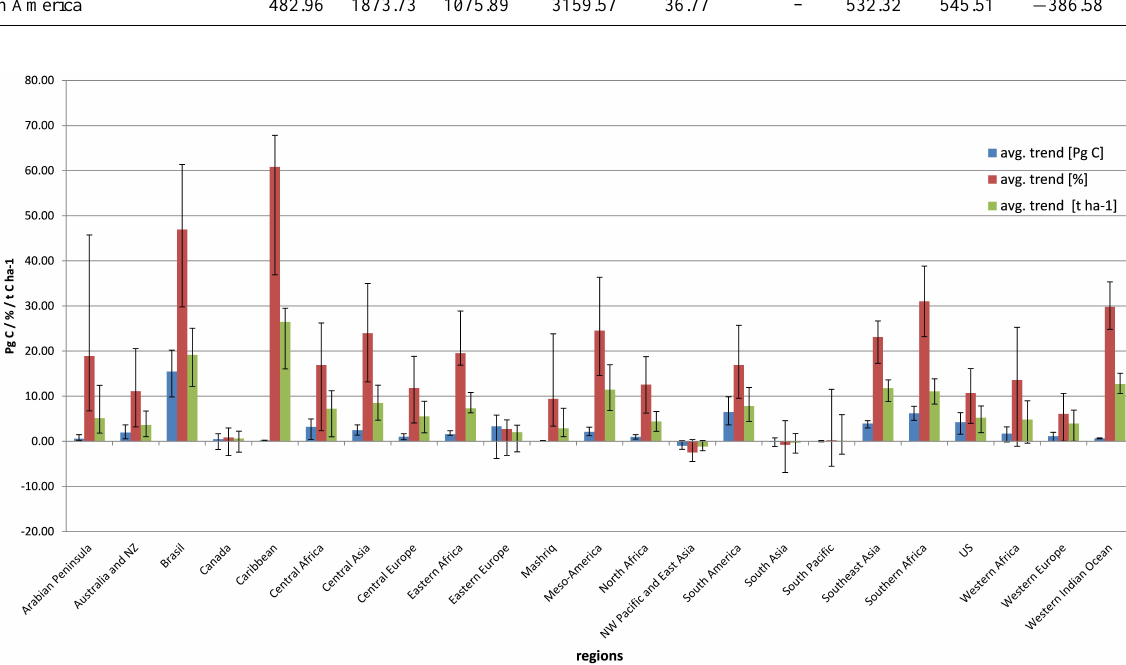
Fig. 10. Regional trends of average (of all scenarios) total SOC stocks, SOC concentrations and % change and respective minimum and maximum values of all